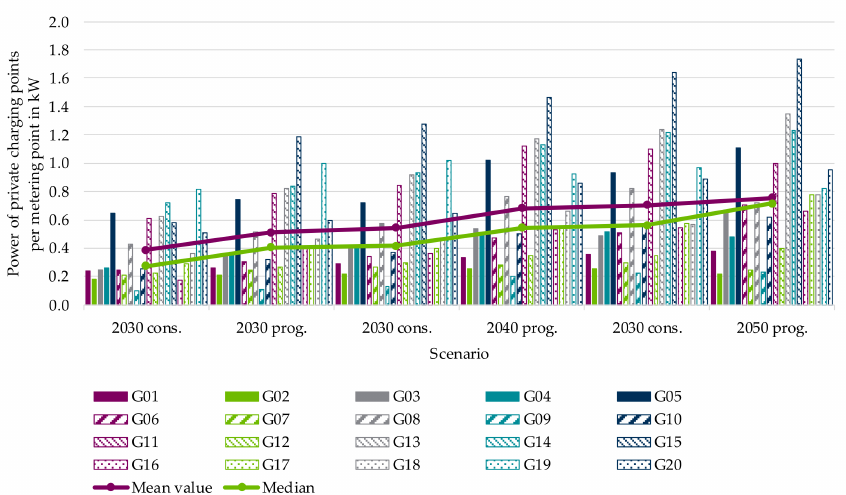
Figure 22. Average effective charging power of private charging points per metering point from the perspective of local distribution transformers for 20 low-voltage grids based on [41].